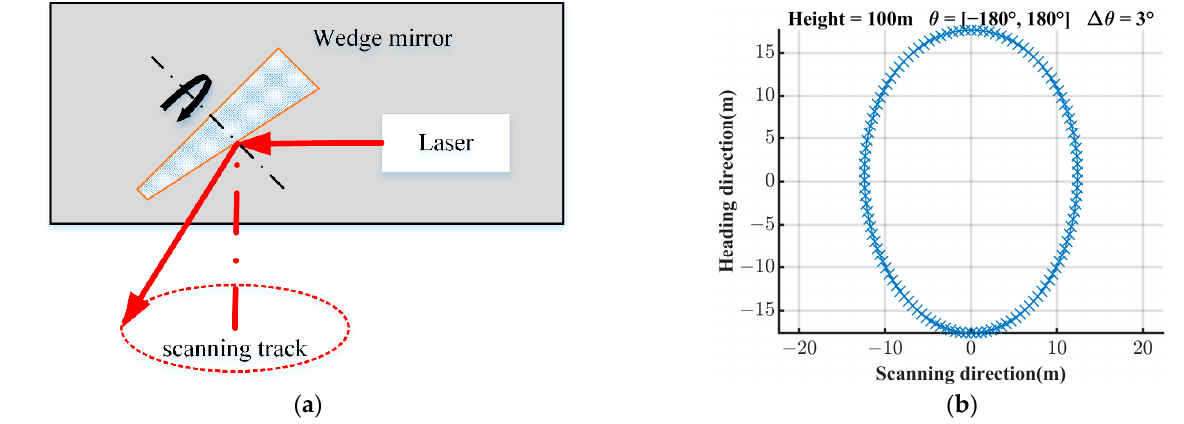
Figure 8. Wedge mirror scanning mode. ( a ) Scanning schematic diagram; ( b ) Scanning track with a height of 100 m, a motor rotation angle of ±180° , and an interval angle of 3° between points.